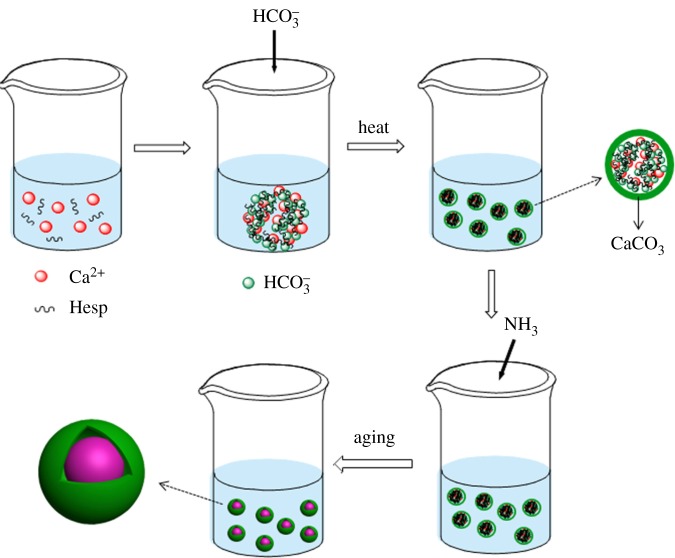
The preparation process of the core–shell CaCO3 microspheres.